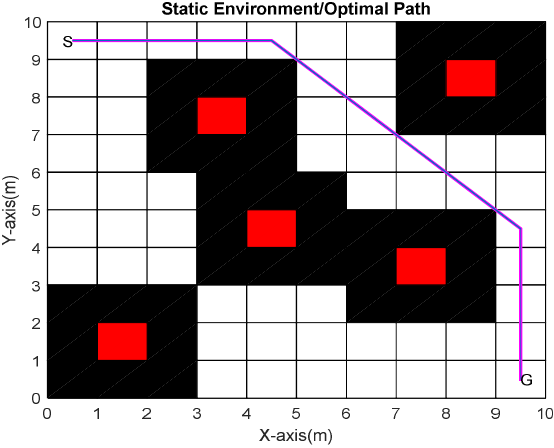
Fig. 20. Best Path found by Modified ACO for Experiment 2